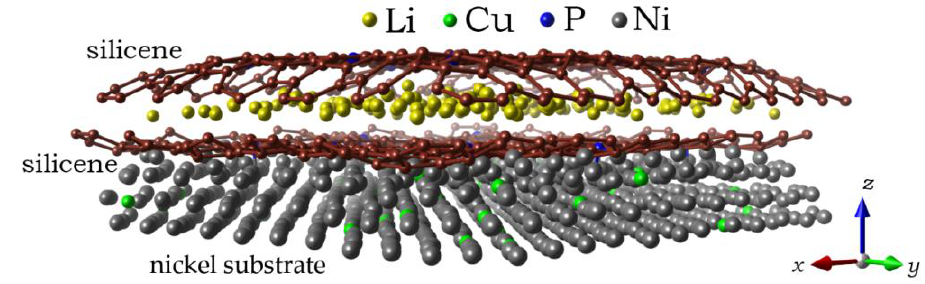
Figure 9. A lithium-filled channel with a 0.75 nm gap between the silicene sheets after 150 ps; the channel walls are doped with 3% phosphorus; a Ni substrate with 5% doping with Cu is used; the figure shows only the three closest to silicene channel layers of the metal substrate. Reprinted with permission from Ref. [39]. 2021, Elsevier.